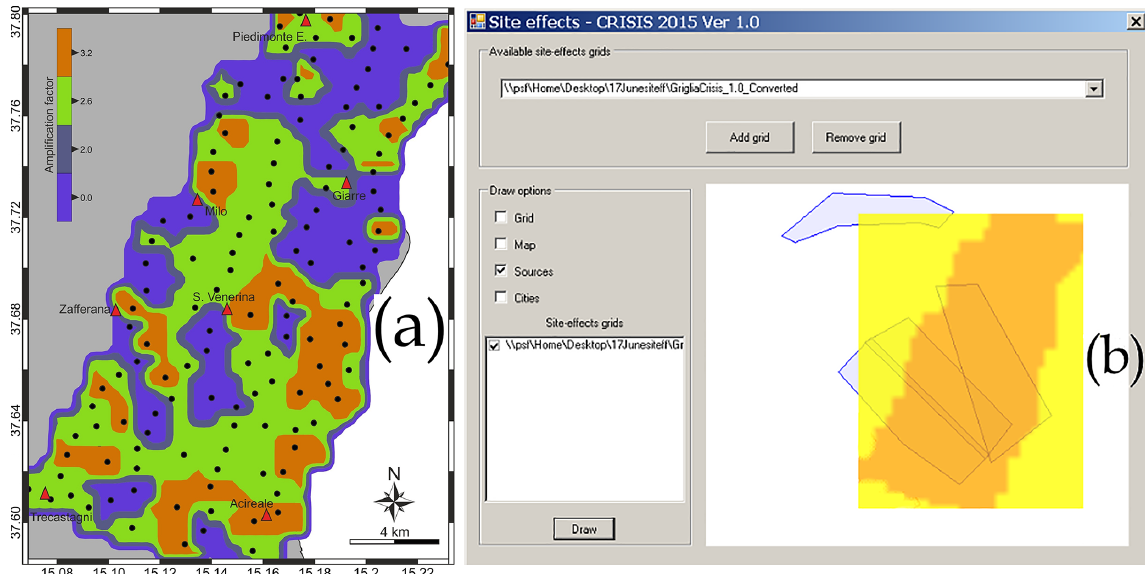
Figure 8. Simplified site-specific response along Mt. Etna’s southeastern flank. (a) Amplification factors at SA 0.2s, obtained by interpolating the measured sites using the nearest neighbor algorithm. (b) Amplification factors as implemented in CRISIS; orange stripe represents the area where amplification factors enter in hazard